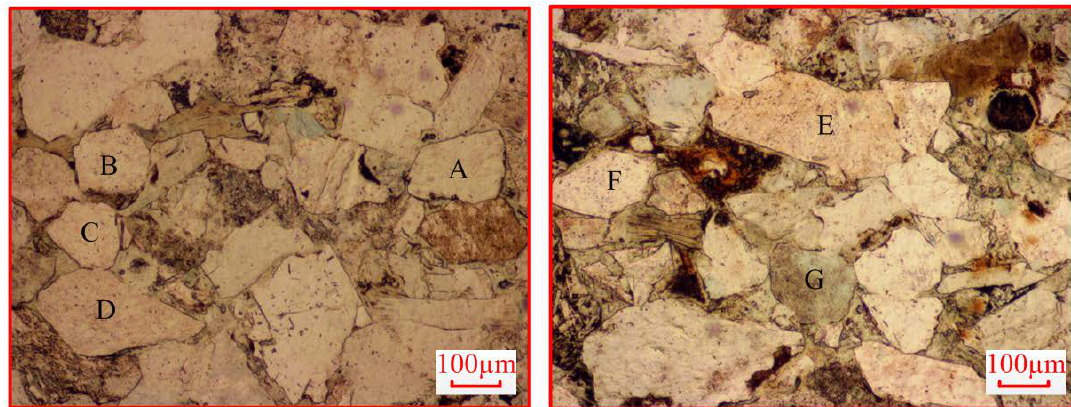
Figure 11. Crack distribution in the lateral direction during the creep tests. Some grains separated from the matrix as a result of the cracks. The intergranular cracks are conspicuous. The loading stress separates the grain from the matrix. The grains from A to G have pronounced edges compared to the matrix.